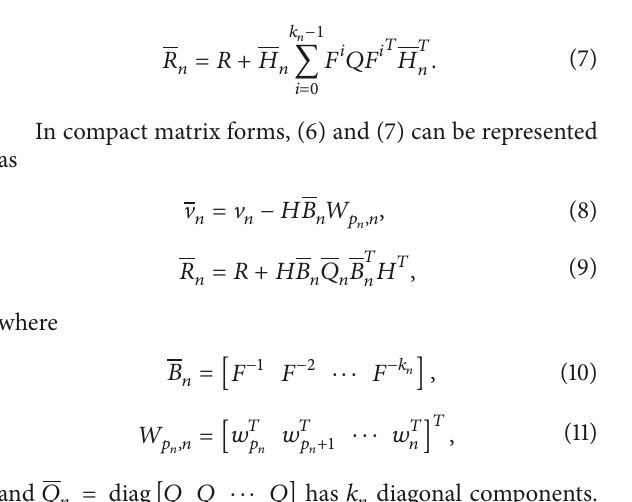
𝑇 } of V 𝑛 is given 𝑛